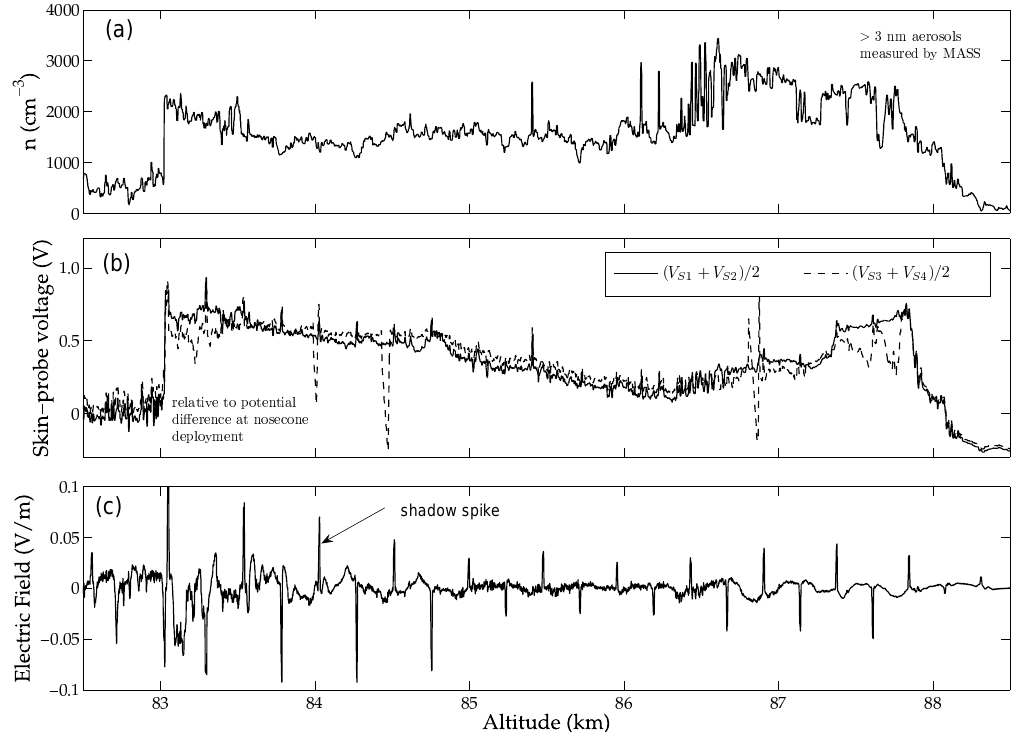
Fig. 4. An overview of the cloud layer. (a) Number densities of the heaviest aerosols measured by the MASS instrument, as a function of altitude (Robertson et al., 2009). (b) Change in the rocket-skin potential, with respect to the probe potential below the PMSE event, as a function of altitude. The solid line is with respect to the average of probes V1 and V2, and the dashed line is with respect to the average of probes V3 and V4. Notice how the profile follows the profile of the large negative aerosols. Large spikes in the V S 3 + V S 4 data at 84, 84.5, and 87km are due to ACS valve firings. (c) The E 12 field, measured by probes V1 and V2 – that is, the field perpendicular to the rocket velocity. The v × B electric field associated with the rocket velocity across the Earth’s magnetic field has been subtracted. The sharp, periodic spikes are shadowing spikes, caused by the probe moving into the shadow of the rocket.